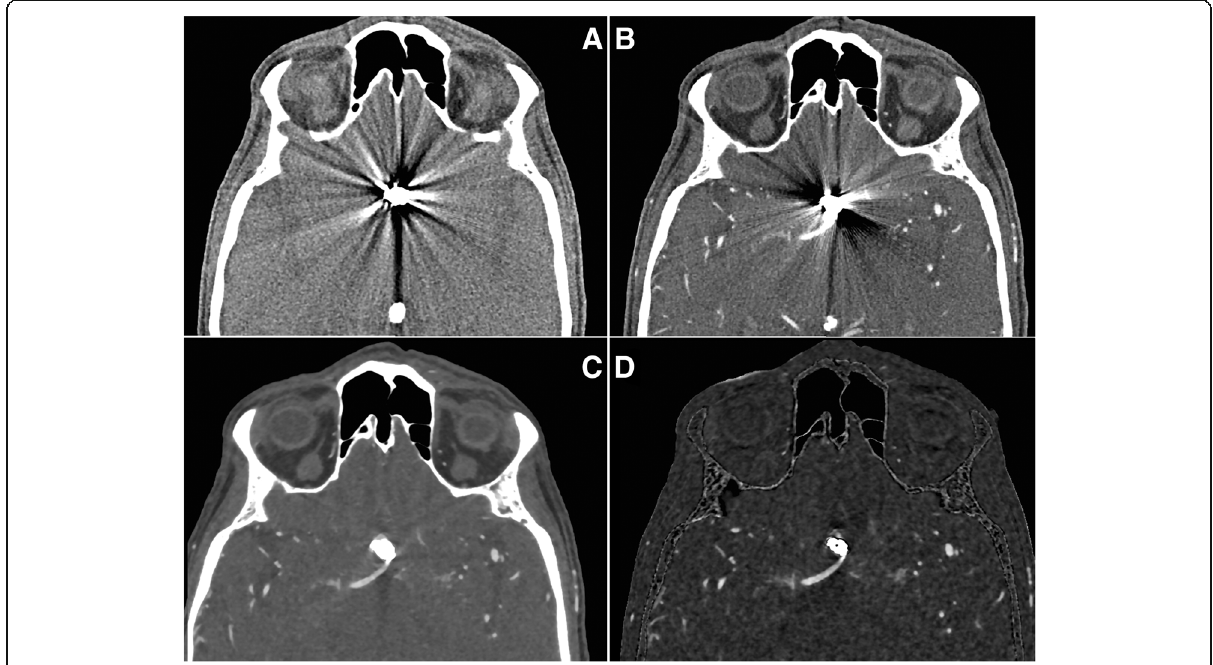
Fig. 1 Impact of post-processing on image quality and metal artifact reduction. a Non-enhanced CT and b CT angiography with pronounced scattering artifacts of a coil-treated anterior communicating artery aneurysm. c CT angiography with metal artifact reduction (MAR) and model- based iterative reconstruction (MBIR) providing substantial artifact reduction. d Subtraction CT angiography with MAR and MBIR filtering providing further artifact reduction and resulting in adequate image quality for diagnostic